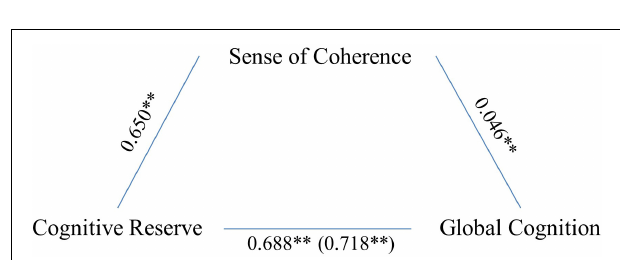
FIGURE 3 | Sense of coherence as a partial mediator of the association between CR and working memory. Values are B coefficients (* p < 0.05; ** p < 0.01); values within parentheses represent total relationship.